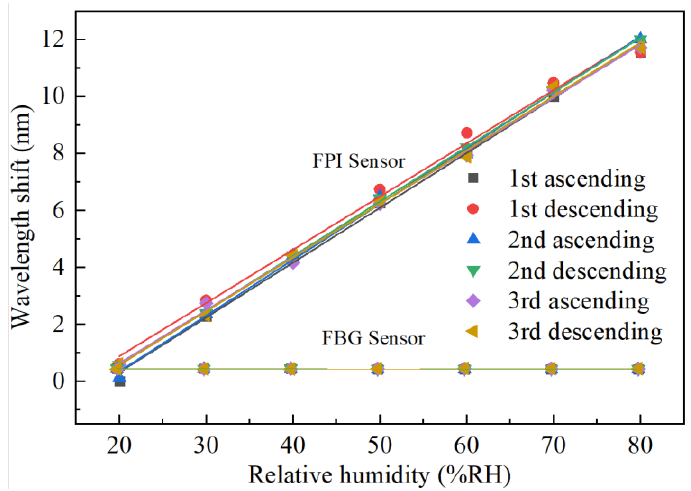
Figure 6. Wavelength shift against RH for three times repetitive measurements of the FPI probe.